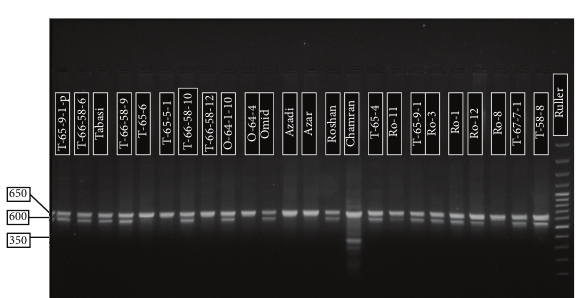
Figure 1: Agarose gel (1.7%) for P1P2 (Dy10 and Dy12).